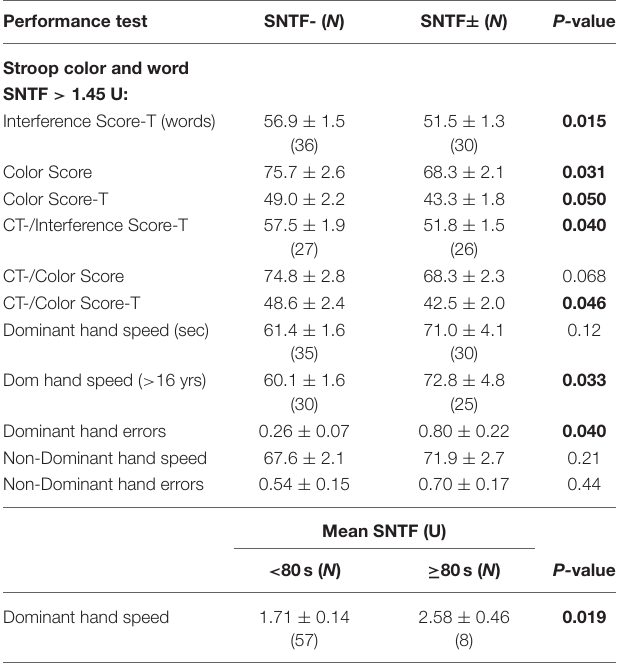
TABLE 2 | Serum SNTF on the day of mild TBI relates to cognitive and sensory-motor performance scores at 3 months post-injury. Performance test